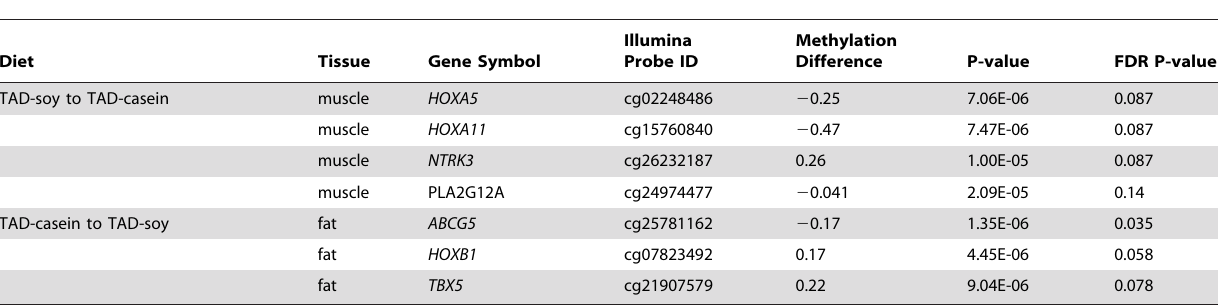
Table 3. Genes with significant DNA methylation changes (FDR P , 0.20) after the diet switch.